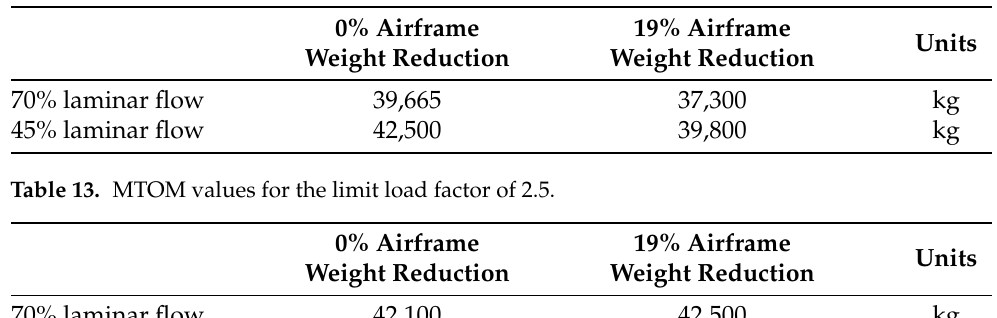
Table 12. MTOM values for the limit load factor of 1.5.